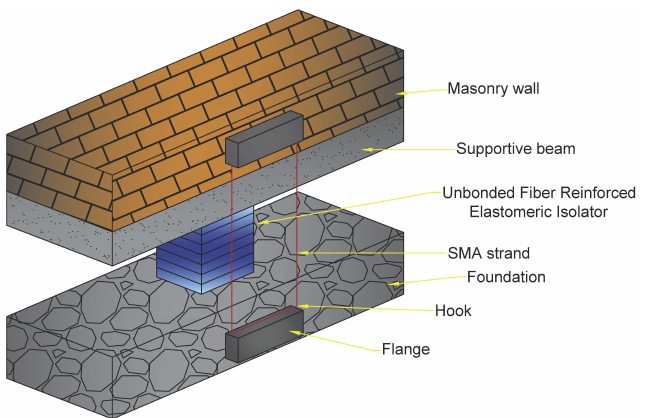
Figure 13. The schematic of the proposed system and SMA strand in the isolation system of masonry constructions